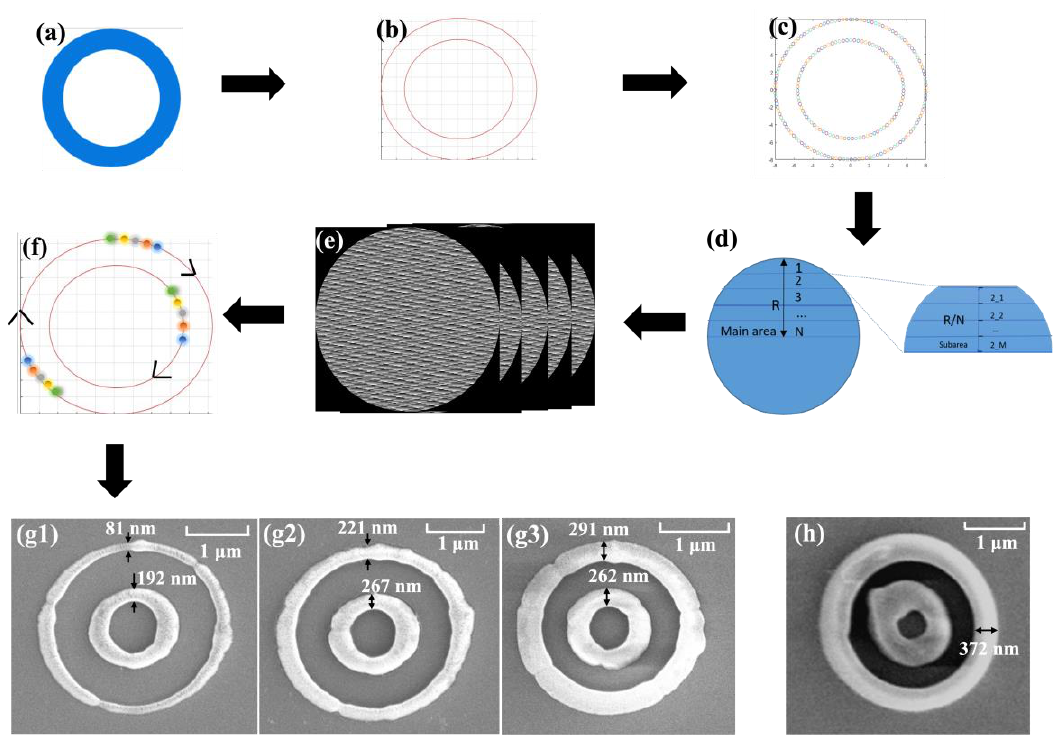
Figure 6. Fabrication of a small – area concentric circle structure with one and three Bessel – Gaussian laser spots, respectively. ( a ) Interpret the SVG into mathematical equations, with a concentric circle pattern as example. ( b ) Construct the outline of the concentric circle. ( c ) Discrete the outline into coordinate points ( Δ𝑥 , Δ𝑦 ). ( d ) The phase maps sequence is generated by the SSP method . ( e ) Generate phase maps with three Bessel – Gaussian laser spots and their movements. ( f ) According to the coordinates through path designing, where the arrows represent the direction of the fabrication path. (g1 – g3 ) Final fabrication results with a single Bessel – Gaussian laser spot, where the laser power is ( g1 ) 2.6 mW, ( g2 ) 3.3 mW, and ( g3 ) 4 mW respectively. ( h ) Final fabrication result with three Bessel – Gaussian laser spots, where the laser power is 12 mW. Here, 𝑑 = 0.39 μm and ∆𝑑 = 0.07 μm. The exposure time for a single phase map is 17 ms.